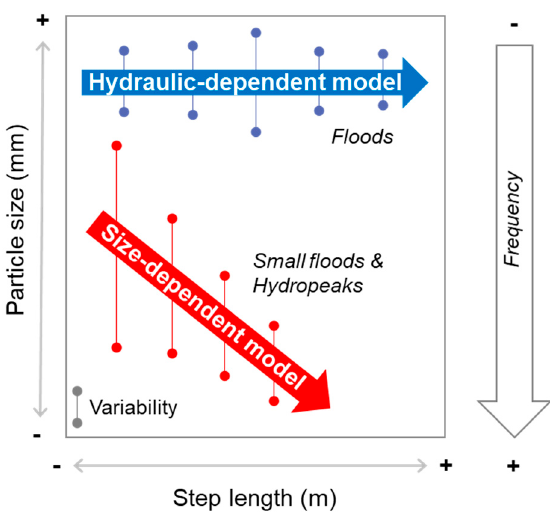
Figure 13. Conceptual diagram showing the two general bed mobility models in hydropeaked rivers according to their frequency of occurrence.